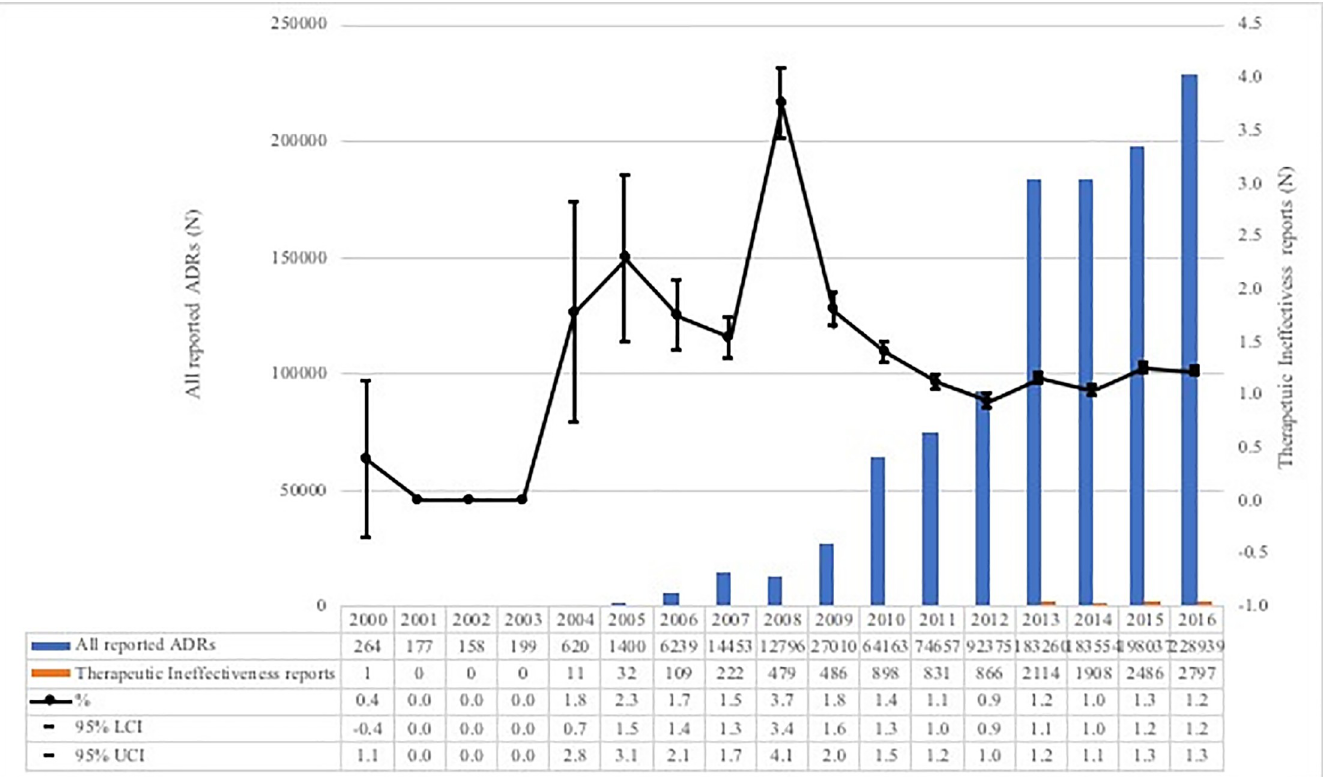
Fig 1. Trends and proportion of therapeutic ineffectiveness reports compared with all reported ADRs from the KAERS database between January 2000 and December 2016.